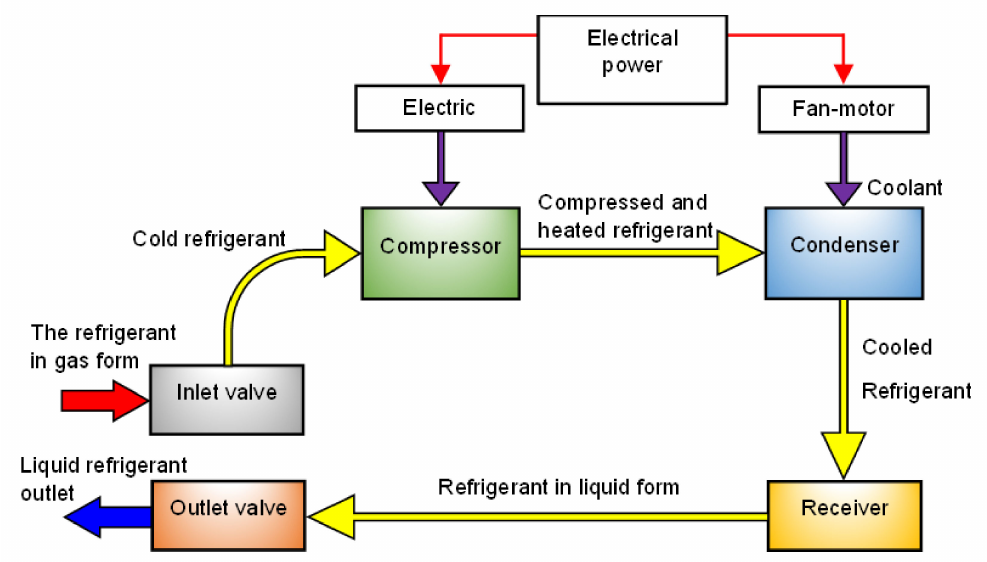
Figure 5. Schematic diagram of a condensing